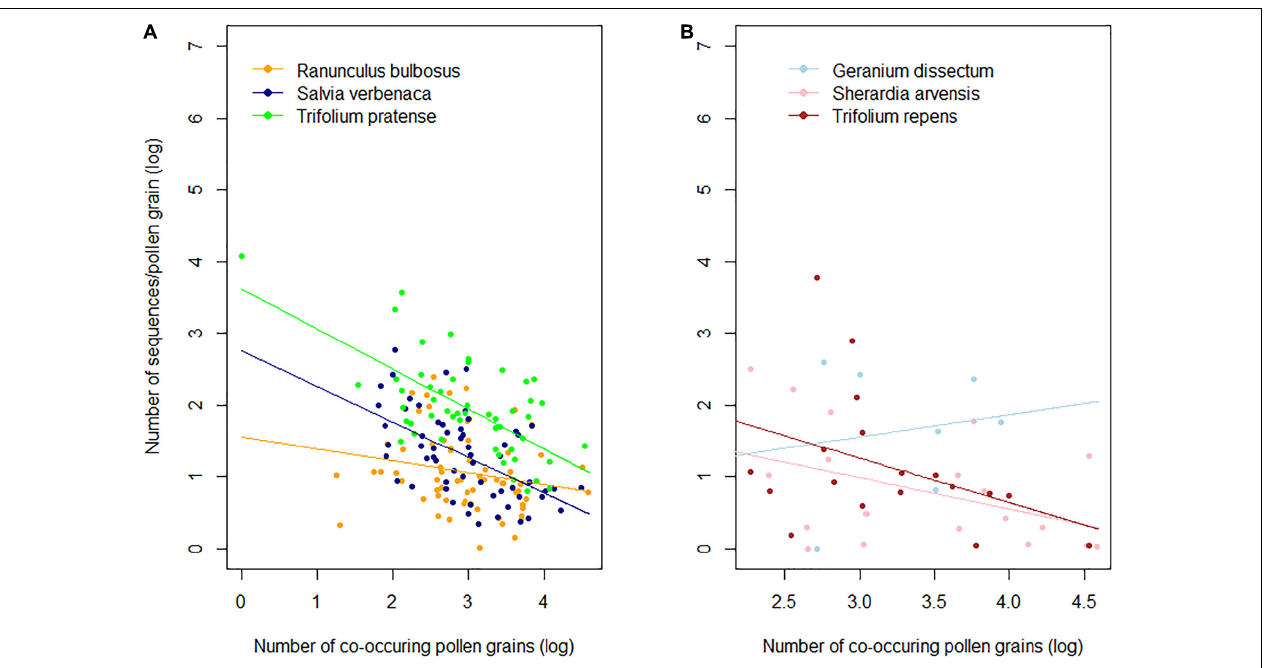
FIGURE 4 | Relationship between pollen abundance of co-occurring species in Bombus terrestris pollen loads and the sequence yield of (A) frequently visited (non-parametric Kendall’s correlations) and (B) rarely visited plant species (linear mixed model; see Supplementary Table 8 for model parameters). All values are log 10